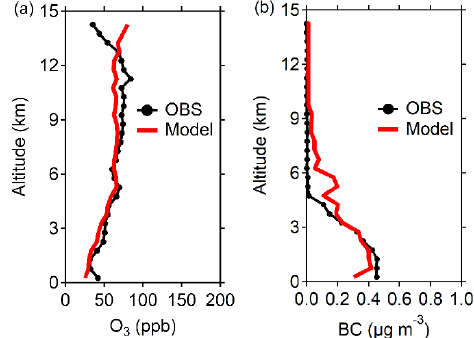
Figure A3. Comparison of (a) O 3 mixing ratio and (b) black car- bon (BC) mass concentration averaged from all flight measurements (OBS) and WRF-Chem simulations (Model), all at STP.